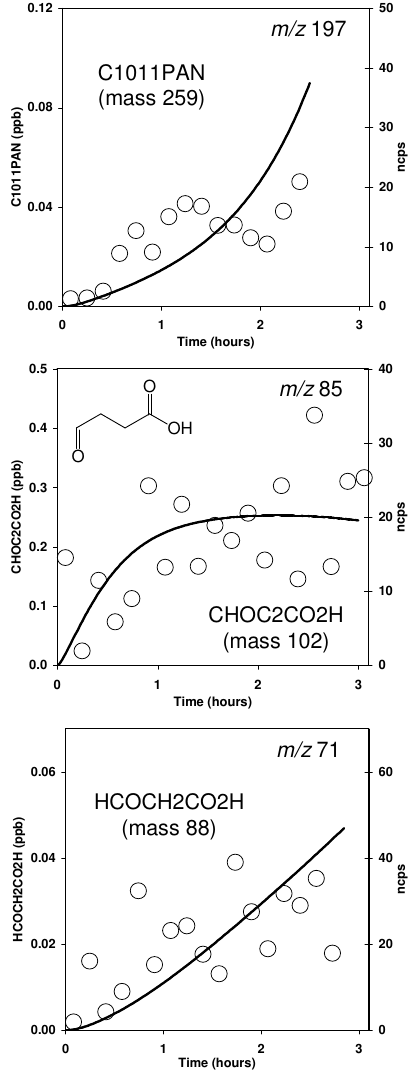
Fig. 19. Example time profiles for additional products simulated Figure 19. Example time profiles for additional products simulated to be relatively abundant 2 to be relatively abundant in the gas phase (lines), compared with in the gas phase (lines), compared with tentative product ion signals measured using CIR-3 tentative product ion signals measured using CIR-TOF-MS (points), during ACES photo-oxidation experiments. Measured signals are TOF-MS (points), during ACES photo-oxidation experiments. Measured signals are presented 4 presented as normalised counts per second (npcs), for the daughter as normalised counts per second (npcs), for the daughter ions identified in Table 3. 5 ions identified in Table 3. Comparisons are for experiments 04-07- 08 ( m / z 197), 10-07-08 ( m / z 85) and 03-07-08 ( m / z 71). Structures Comparisons are for experiments 04-07-08 ( m/z 197), 10-07-08 ( m/z 85) and 03-07-08 ( m/z 6 for C1011PAN and HCOCH2CO2H shown in Fig. 71). Structures for C1011PAN and HCOCH2CO2H shown in Fig. 5. 7